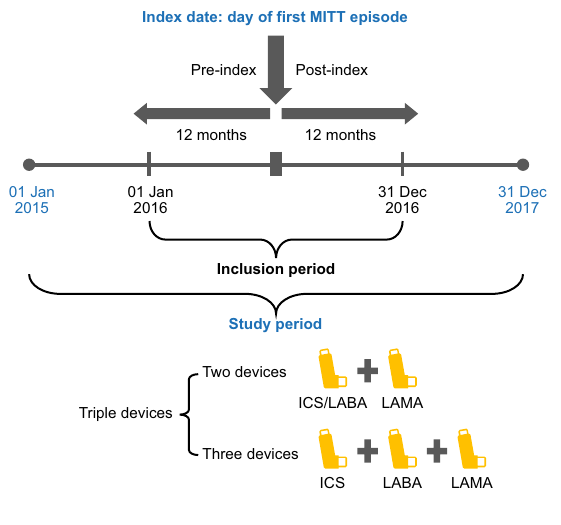
Fig. 1 Study design. ICS inhaled corticosteroid, LABA long-acting β 2 -agonist, LAMA long-acting muscarinic antagonist, MITT multiple- inhaler triple